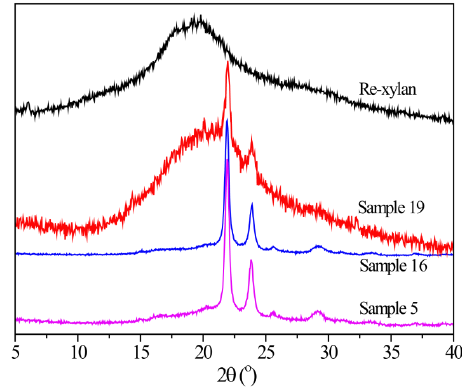
Figure 6. XRD patterns of regenerated xylan, and xylan- g -PPDO samples 5 (WPG = 431.07%), 16 (WPG = 239.26%), and 19 (WPG = 13.03%).